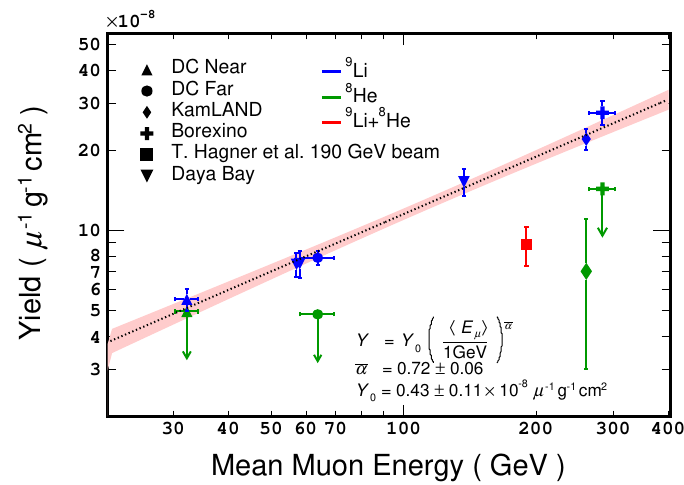
Figure 6 . The ND and FD yields shown separately for 9 Li and 8 He as a function of the mean muon energy h E (cid:22) i , alongside those from KamLAND, Borexino, and Daya Bay. The arrows depict a 3 (cid:27) upper limit and their lengths equal 1 (cid:27) . A (cid:12)t to the 9 Li yields of the ND, FD, Borexino, and KamLAND returns the power law exponent (cid:11) = 0 : 72 (cid:6) 0 : 06 with (cid:31) 2 = d : o : f : = 4 : 0 =